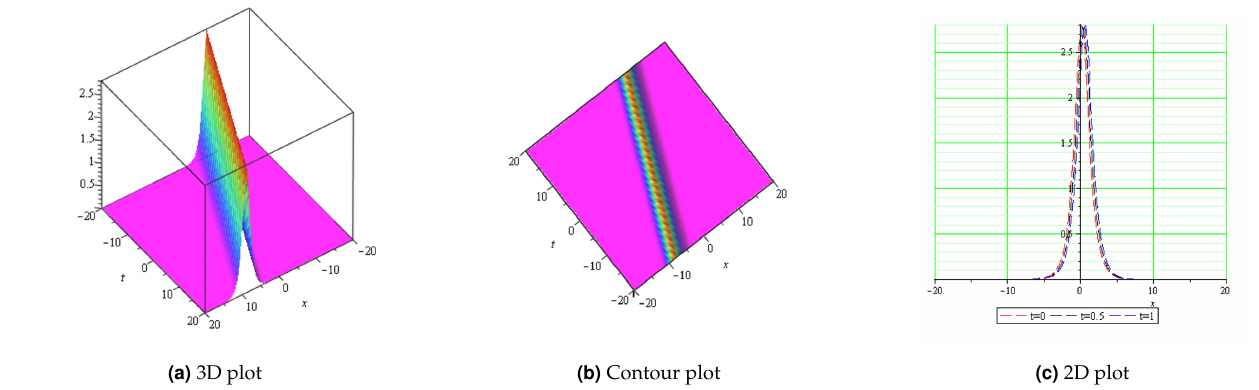
Fig. 1. The obtained the TW solution of Eq 1, when ϱ = 1.2, Ξ = 1.5, Π = 2.5, λ = − 1, with B = 2.6.